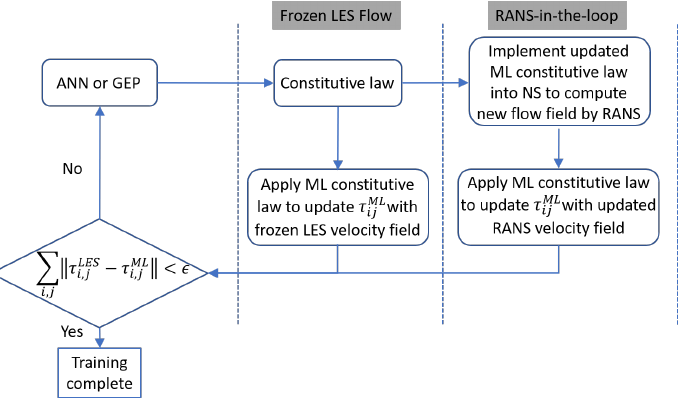
Figure 5. Training verification strategies which can broadly be split into two main categories: frozen training and